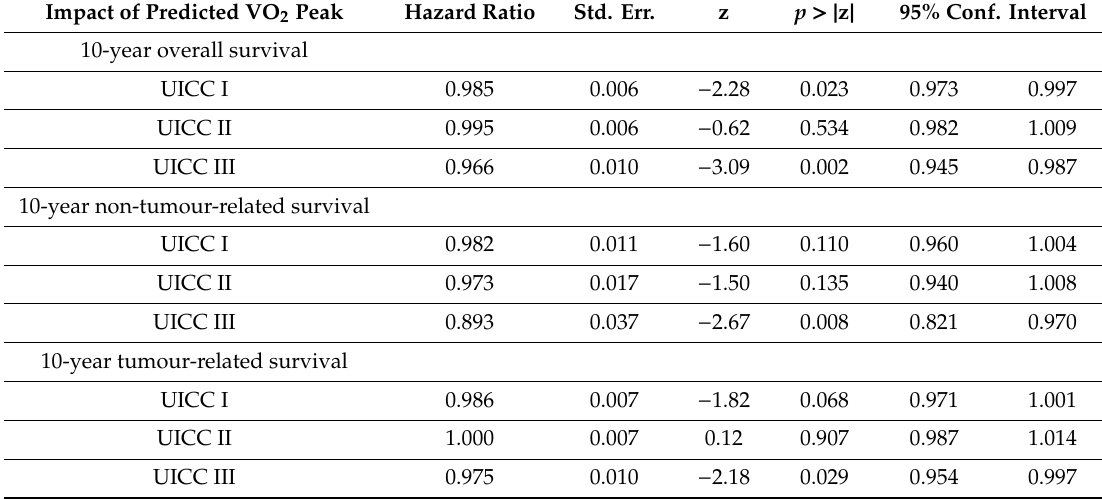
Table 6. Univariable prognostic analysis of predicted VO 2 peak using Cox proportional hazard model, evaluated separately for Union for International Cancer Control (UICC) stages I, II and